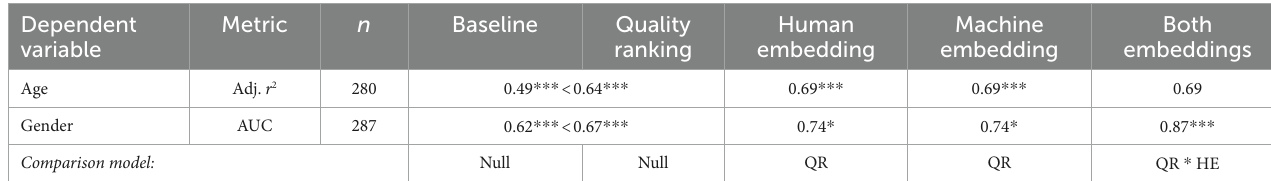
TABLE 3 Model fits predicting demographic characteristics of participants.